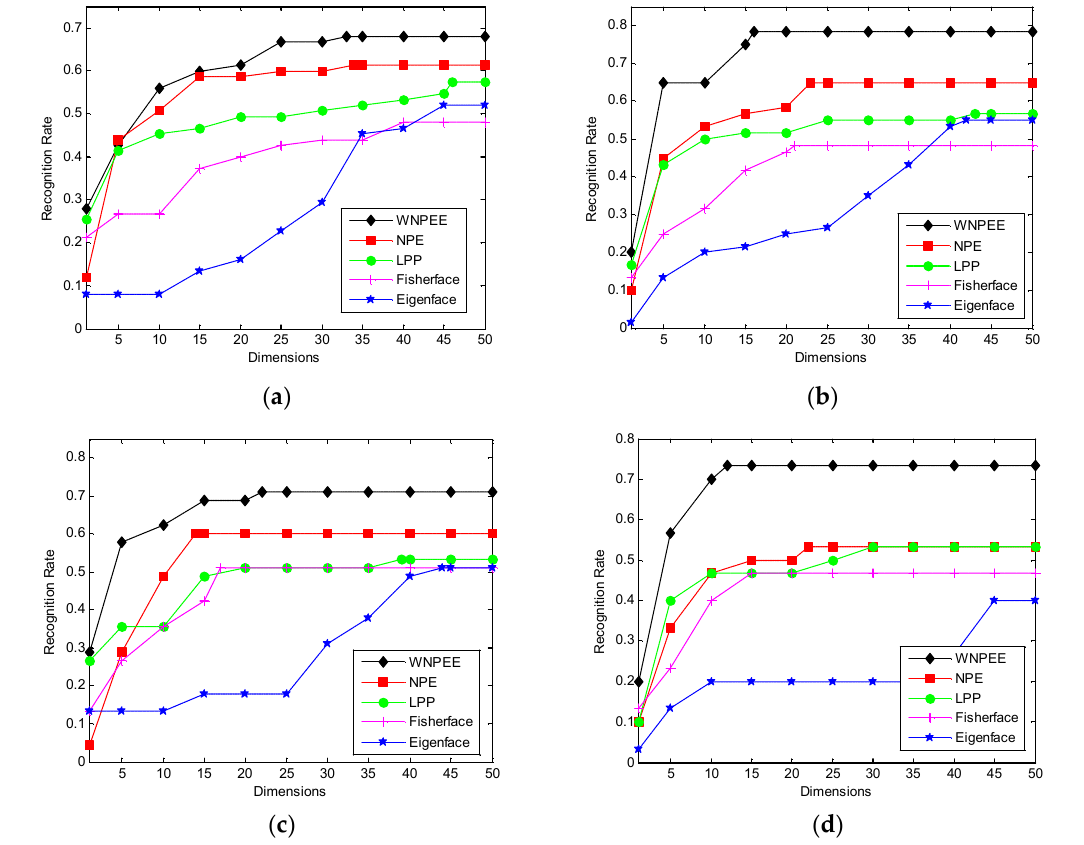
Figure 8. Average recognition rate versus reduce dimensions on YALE dataset. ( a ) l = 6, ( b ) l = 7, ( c ) l = 8, and ( d ) l = 9.